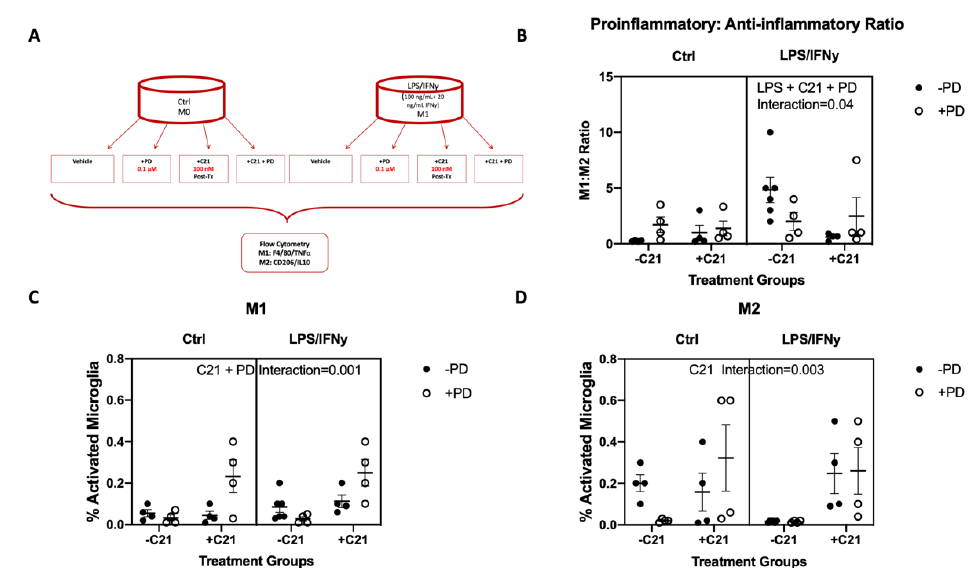
Figure 4. C21 lowers the pro-/anti-inflammatory microglia ratio. ( A ) C8B4 cell line was polarized toward an M1 phenotype with the incubation with both LPS and IFN γ . ( B ) C21 treatment improved the M1:M2 ratio in the LPS/IFN γ group, but only the absence of PD (interaction p = 0.04) ( C ) AT2R blockage with PD increased M1 microglia in both control and LPS/IFN γ treatment (interaction p = 0.001). ( D ) C21 treatment increased M2 cells in both control and LPS/IFN γ groups in the presence and absence of PD (interaction p = 0.003) (n = 4–6/group).